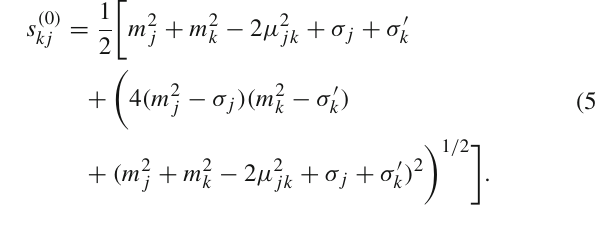
Fig. 10c, with the cut crossing the real axis below